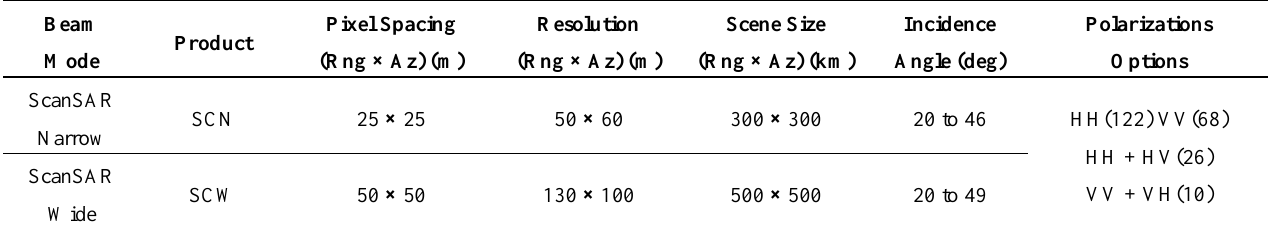
Table 1. Beam mode characteristics. SAR, synthetic aperture